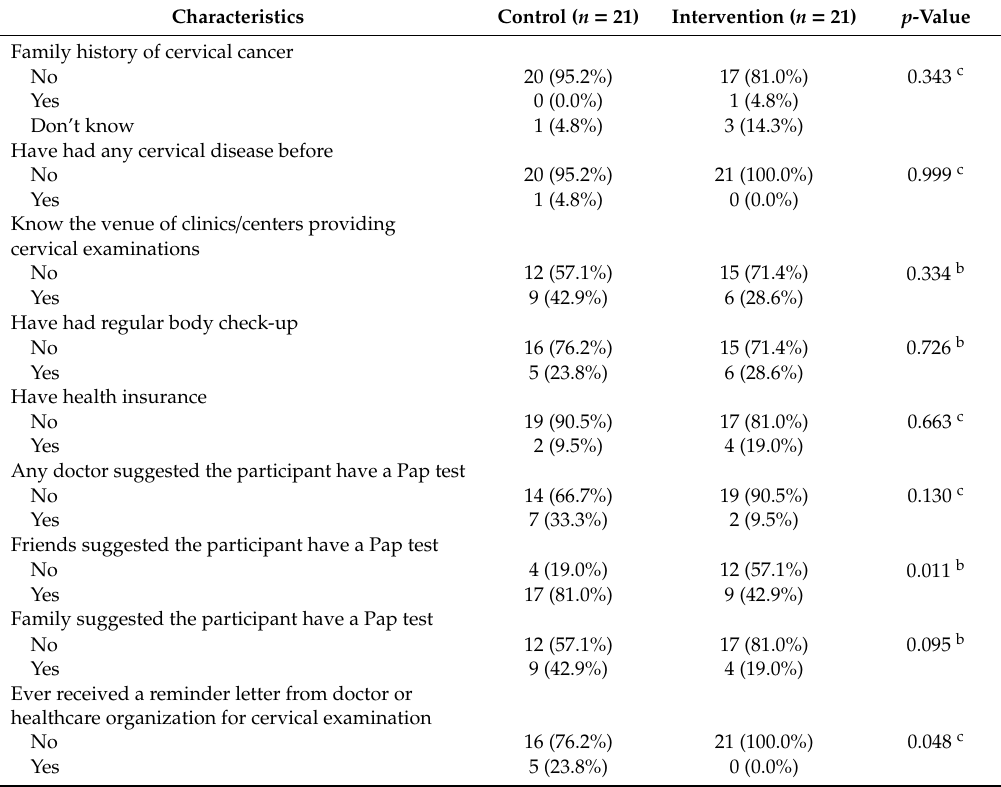
Table 2. Health behaviors related to cervical cancer and